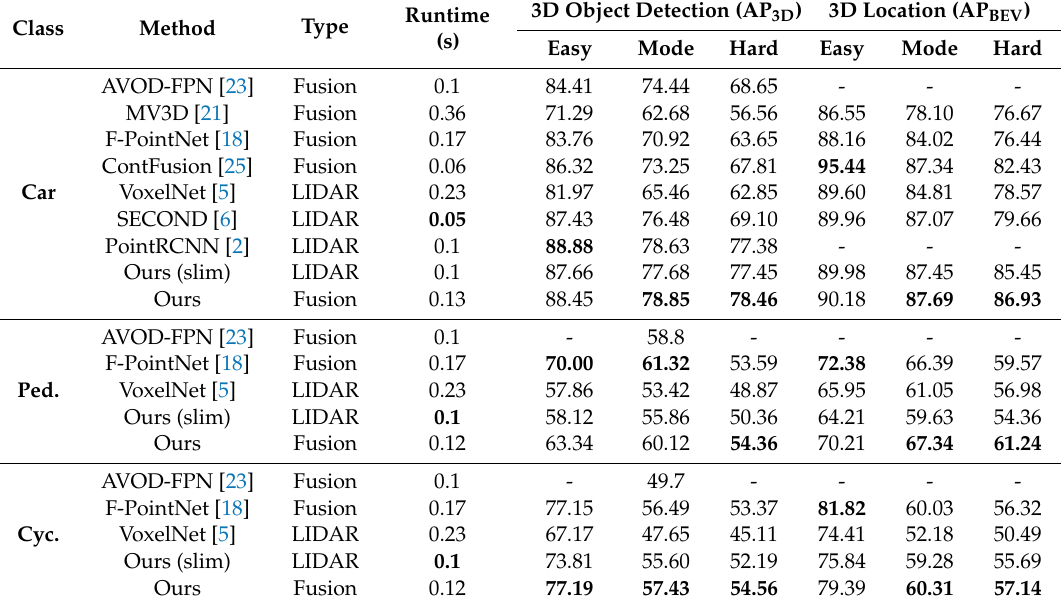
Table 2. Comparison of the 3D object detection and location performance of KDA3D with state-of-the-art 3D object detectors: Average Precision (AP 3D in %) of 3D boxes and Average Precision (AP BEV in %) of bird’s eye view boxes on KITTI’s val set. We use a 3D IoU threshold of 0.7 for the car class, and 0.5 for the pedestrian and cyclist